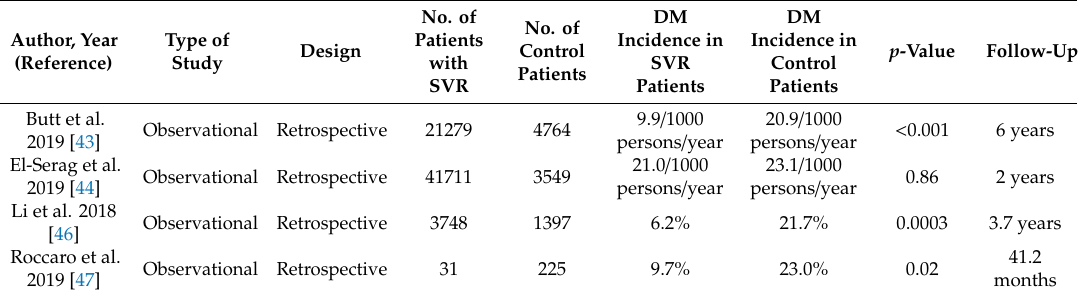
Table 2. Incidence of DM in HCV patients treated with